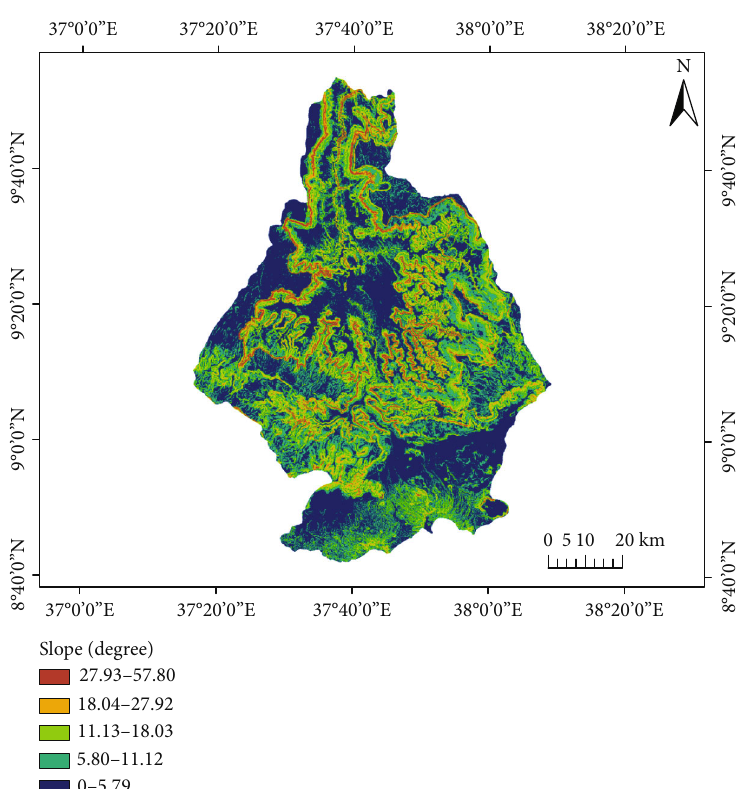
Figure 4: The slope of Guder watershed.